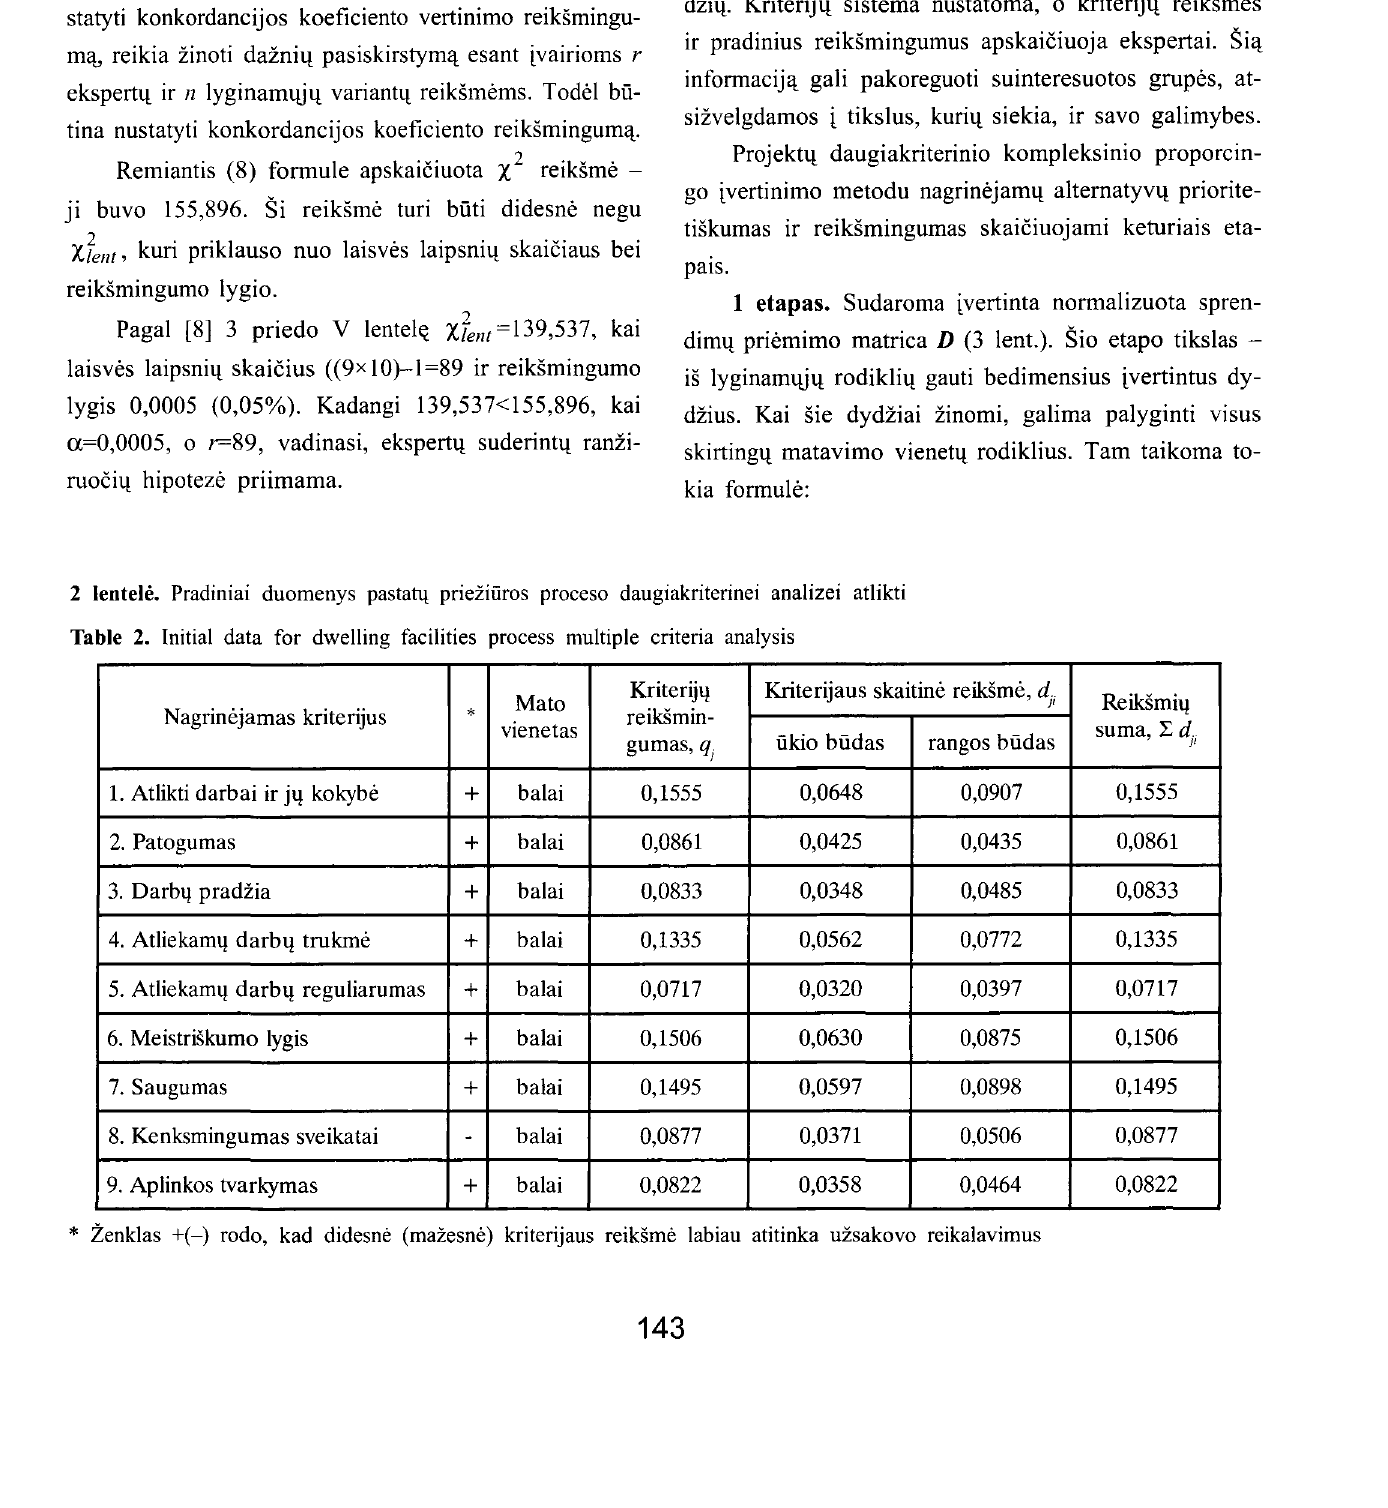
Table 2. Initial data for dwelling facilities process multiple criteria analysis